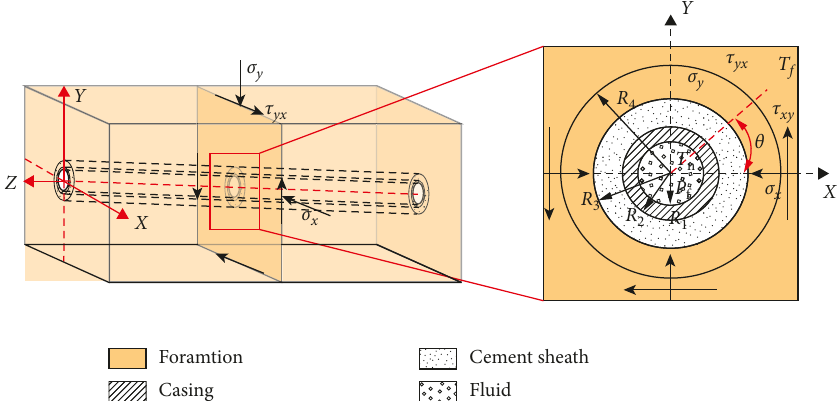
Figure 4: CCF composite assembly. Formation boundary temperature, T f ; internal casing temperature, T n ; internal casing pressure, P i ; radius, R i , i � 1, 2, 3, 4 present the radii of the internal casing wall, outer casing wall, internal wellbore, and formation boundary, respectively; the counterclockwise angle from the x -direction to the calculated point, θ .